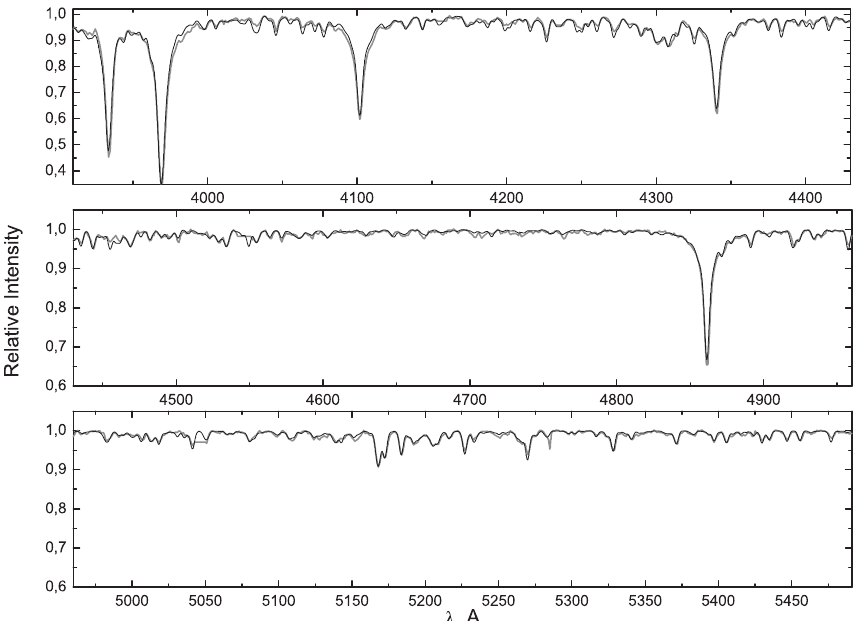
Fig. 2. The computed theoretical spectrum (black curve) compared to the observed spectrum of NGC 7078 (grey